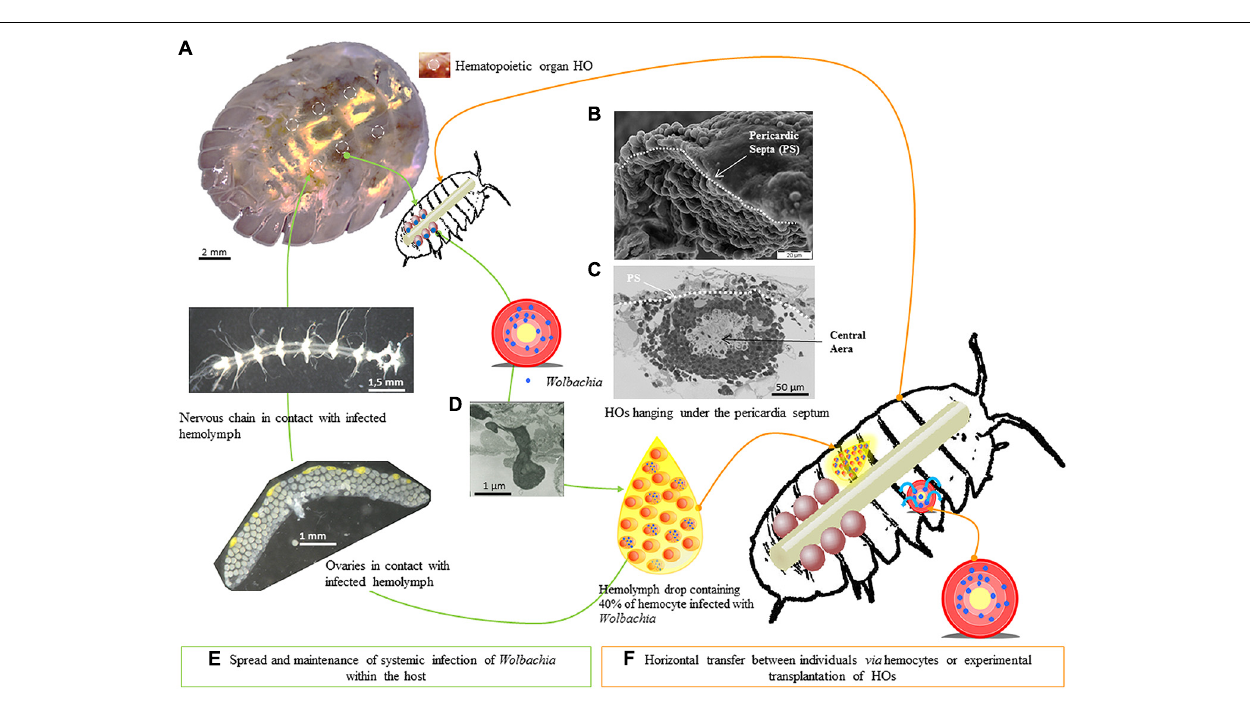
Frontiers in Microbiology | www.frontiersin.org